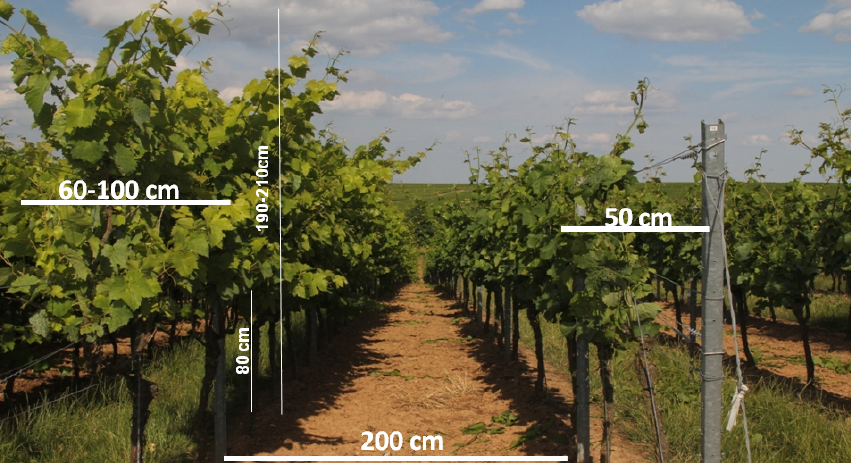
( Left ) A grapevine row trained as a semi-minimal-pruned-hedge (SMPH) system; ( Right ) A grapevine row trained as a traditional vertical shoot positioned (VSP) trellis.